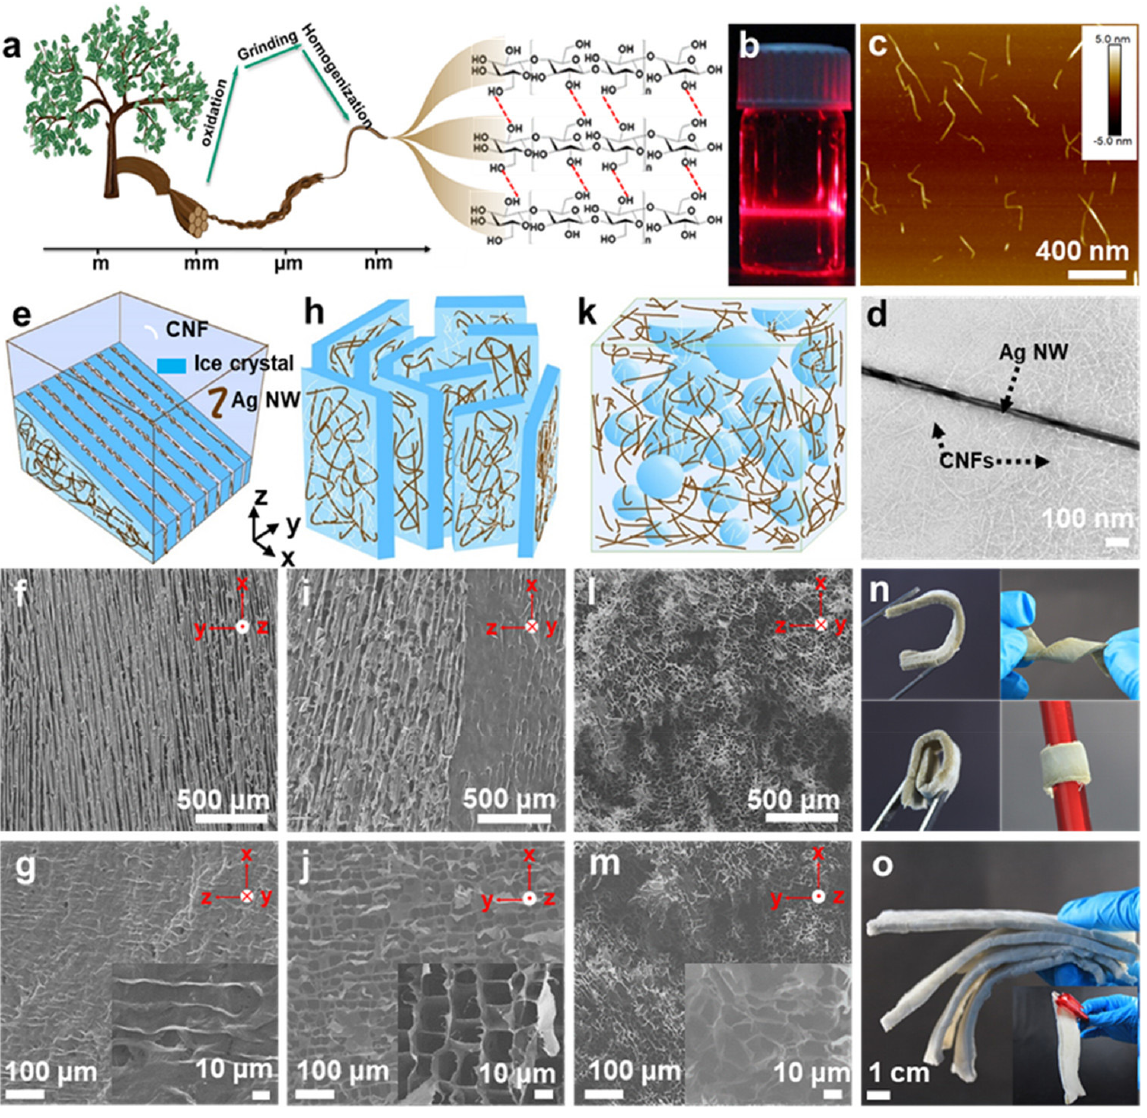
Figure 15. ( a ) Hierarchical structure of CNF and its preparation process. ( b ) Image of the CNF dispersion displaying the Tyndall effect. ( c ) AFM image of pristine CNFs. ( d ) TEM demonstrating good attraction and adhesion between the CNFs and AgNWs. Schematic representation of ice crystals’ growth during various freezing approaches of the CNF/AgNW dispersion and SEM images of the resultant aerogels: ( e – g ) bidirectional, ( h – j ) unidirectional and ( k – m ) uniform/random freezing. ( n ) Bendability, twistability and rollability of these ultralight aerogels. ( o ) Demonstration of large-area lamellar porous CNF/AgNW aerogels with varying densities (inset, a large-area aerogel held up by electrostatic force). Reproduced with permission from [155]. Copyright 2020, American Chemical Society.